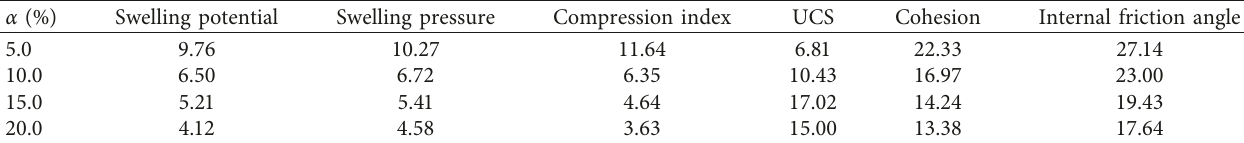
Table 7: The improvement efficiency coefficient of stabilized expansive